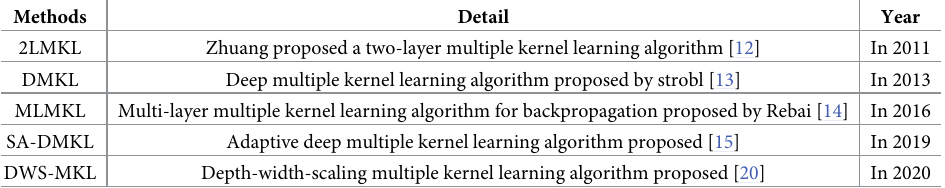
Table 2. Five classical comparison methods.